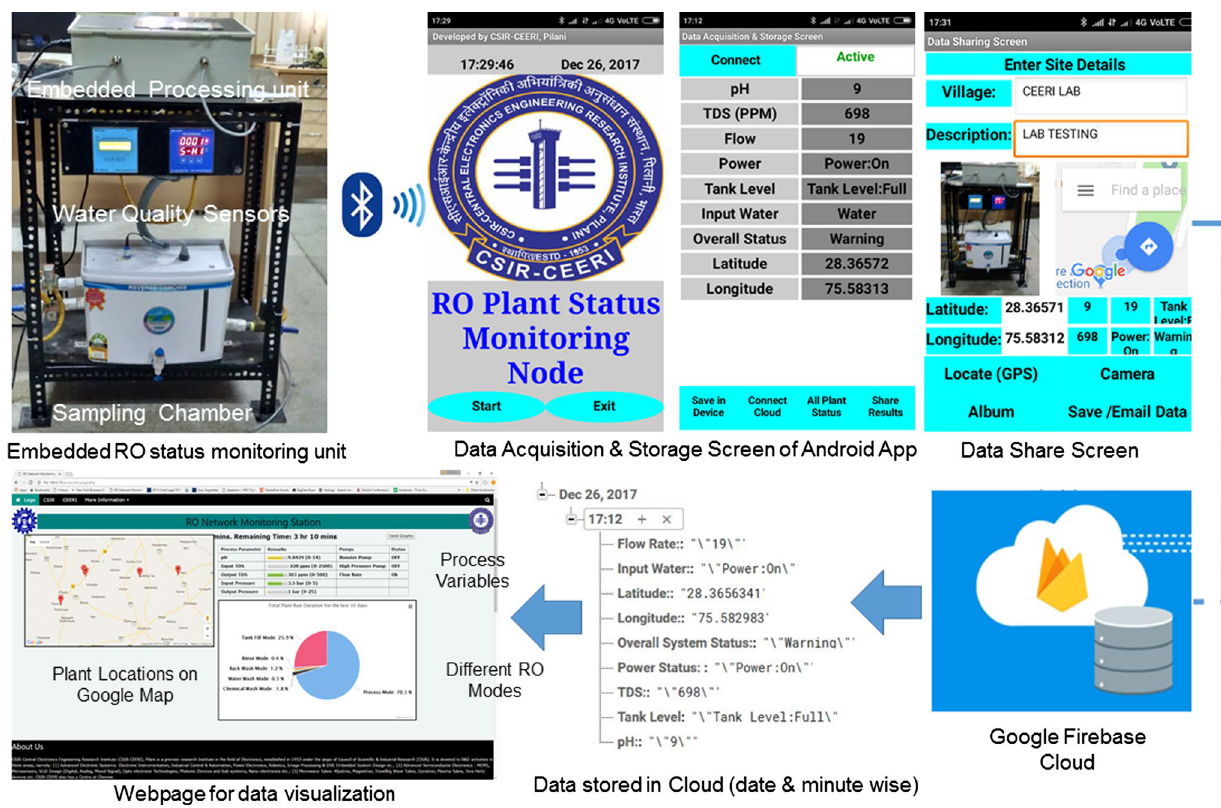
Fig. 5 Overall communication scheme for developed embedded RO plant status monitoring